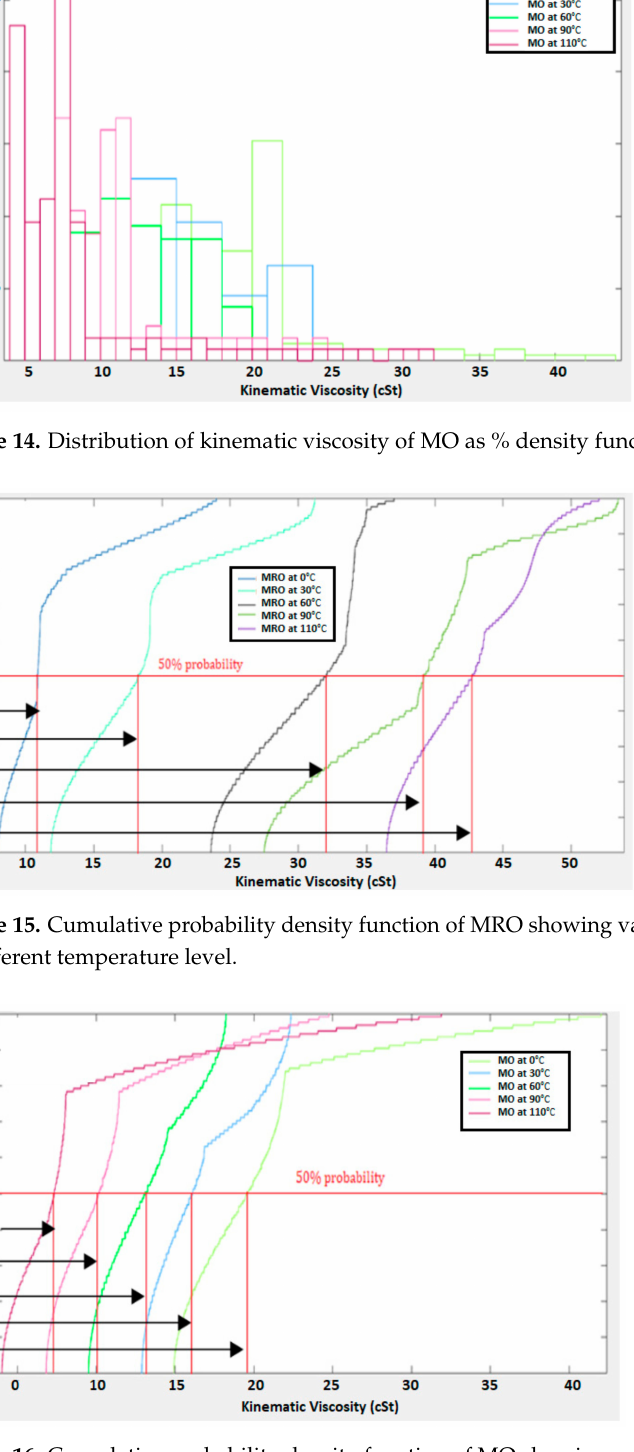
Figure 16. Cumulative probability density function of MO showing variation of kinematic viscosity in different temperature